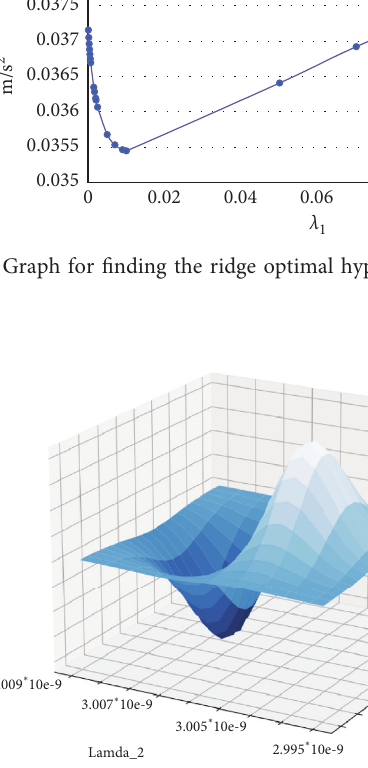
Figure 11: Graph for finding the elastic-net optimal hyperparameters of the 8 th round. Table 3: Detailed values of hyperparameters mean of 15 sets of experiments.